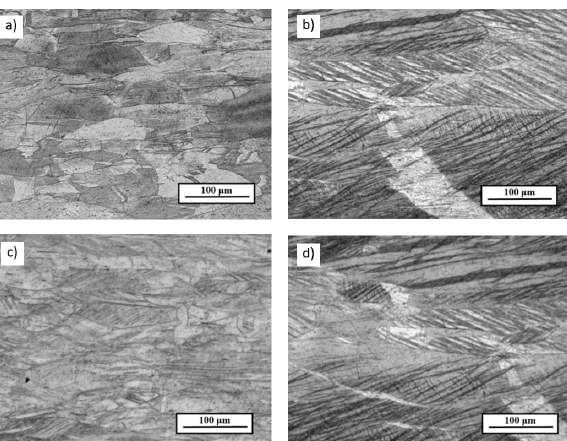
Figure 4: Optical micrographs of CuCrZr after: a) ASaR – 40% RA; b) AScR – 40% RA; c) AScR – 40% RA + HT 480 ∘ C; d) AScR – 40% RA + HT 430 ∘ C.